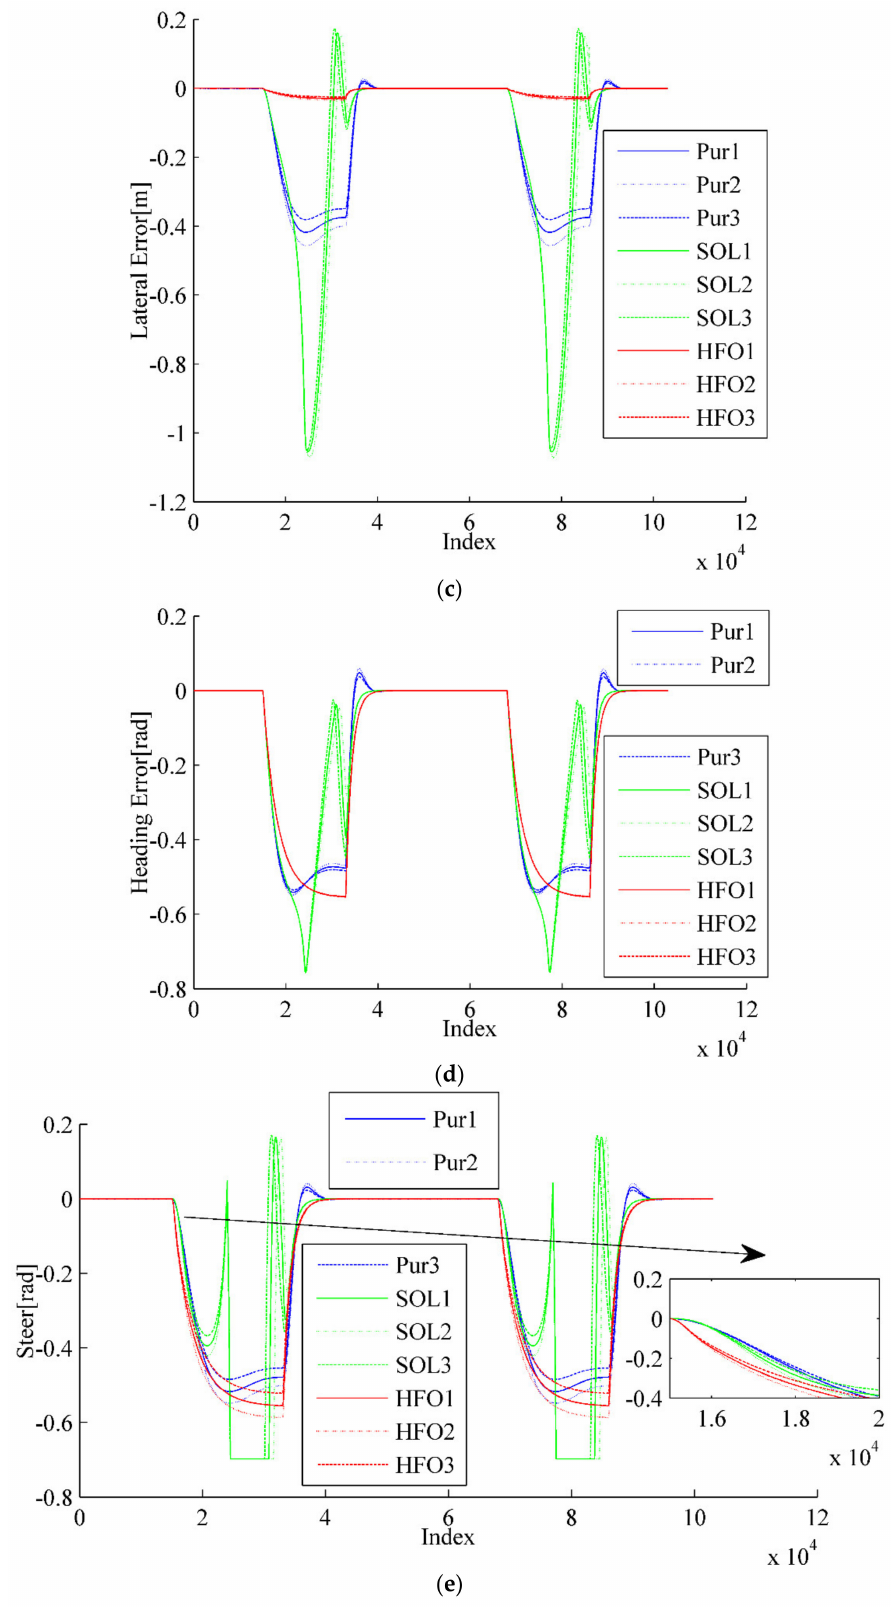
Figure 4. Ring test scenario. ( a ) Trajectory tracking (3D), ( b ) Trajectory tracking (2D), ( c ) Lateral error, ( d ) Heading error, ( e ) Steer